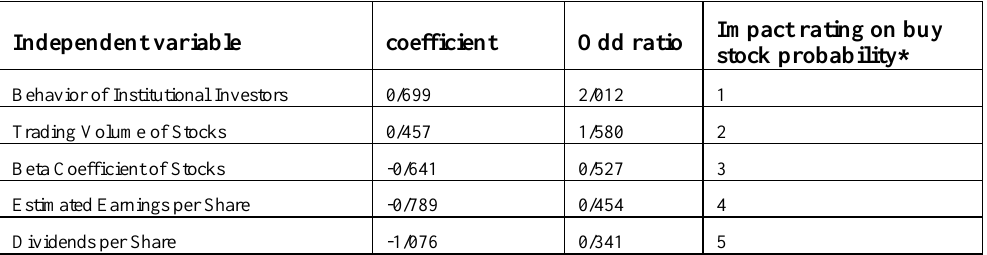
Table 5: Ranking the Impact of the Independent Variable on Buying Shares Probability Independent